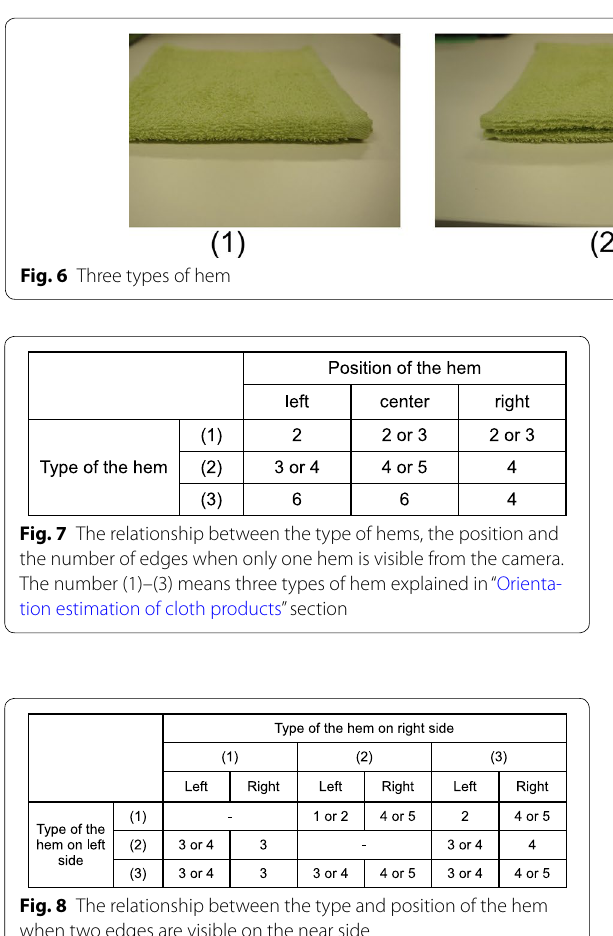
the area painted white is an area used to calculate the number of edges. Results that a hem with red line was recognized as the thickest folded hem.